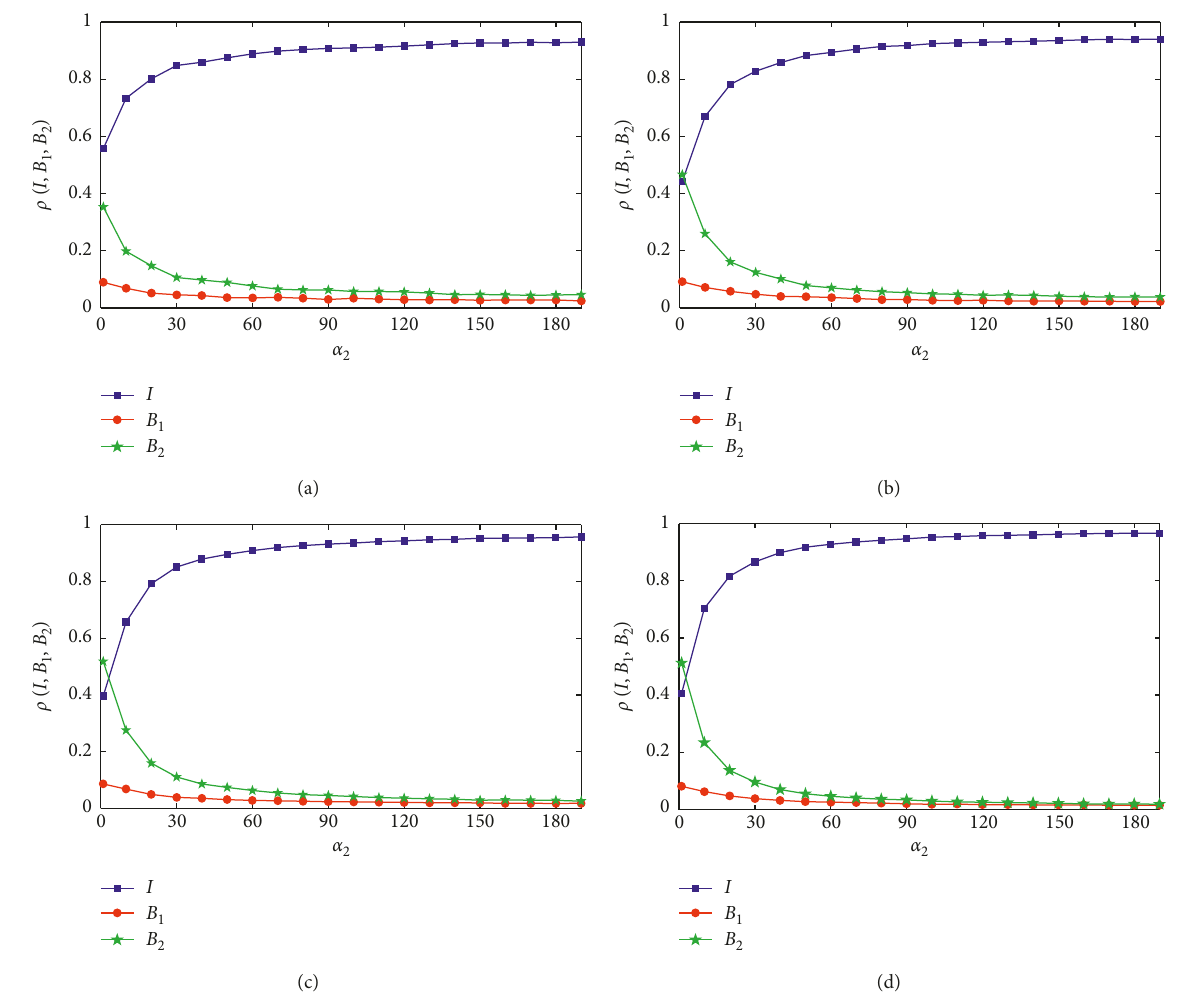
u � 0.4, u � 0.5, α � 3, q � 0.1, u 1 2 1